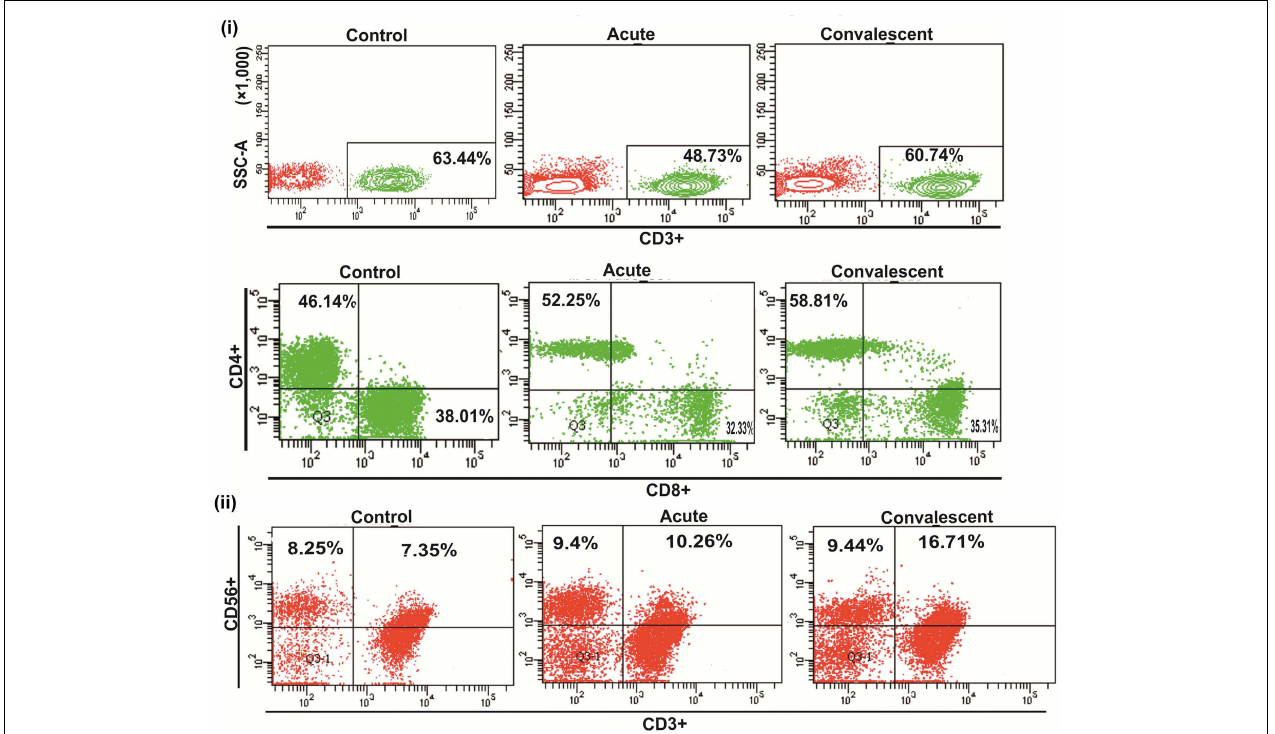
FIGURE 1 | Percentge of lymphocytes popultion. (i) Upper pannel shows the representative figures for CD3 + T cells proportion in control individuals, acute and convalescent patients, lower pannel shows representative figures for CD3 + CD4 + /CD3 + CD8 + T cells proportion in control individuals, acute and convalescent patients. (ii) Shows the representative figures for NK (CD3 − CD56 + )/NKT-like(CD3 + CD56 + ) cells proportion in control individuals, acute and convalescent patients.